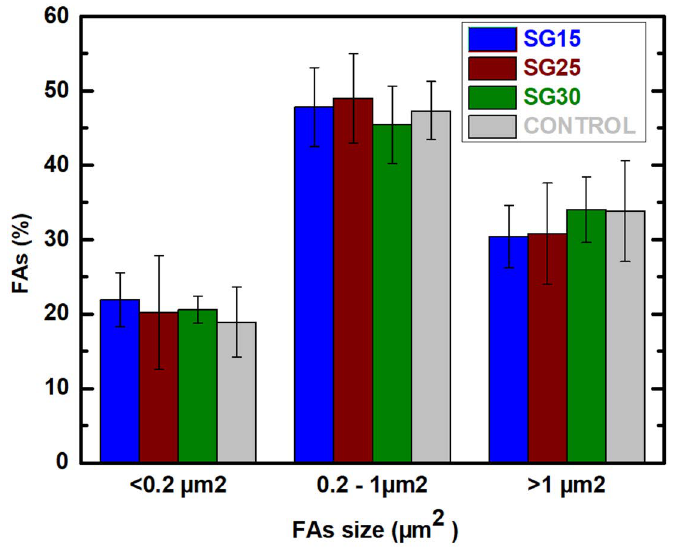
Figure 11. Percentage of FAs according to size in HOB ® cells grown on the described SG15, SG25 and SG30 aerogels after one week of culture. One-way analysis of variance. Statistical significance was defined as p < 0.05.